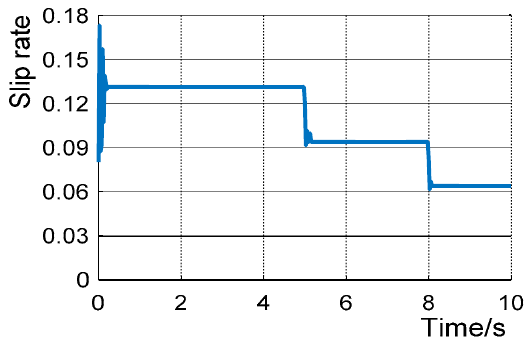
Figure 15. The optimal slip rate curve.